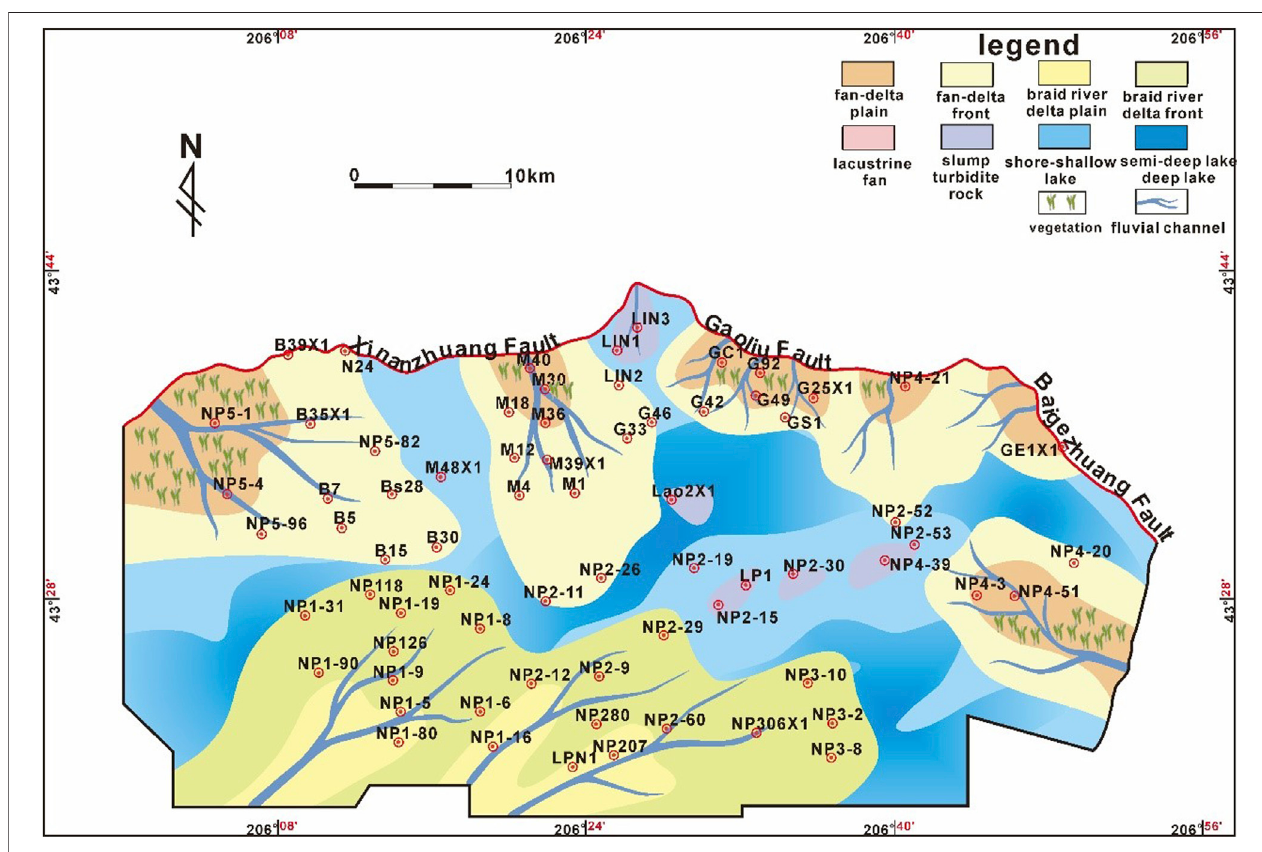
FIGURE 7 | Plane distribution map of the E d 1 sedimentary system in Nanpu Sag.